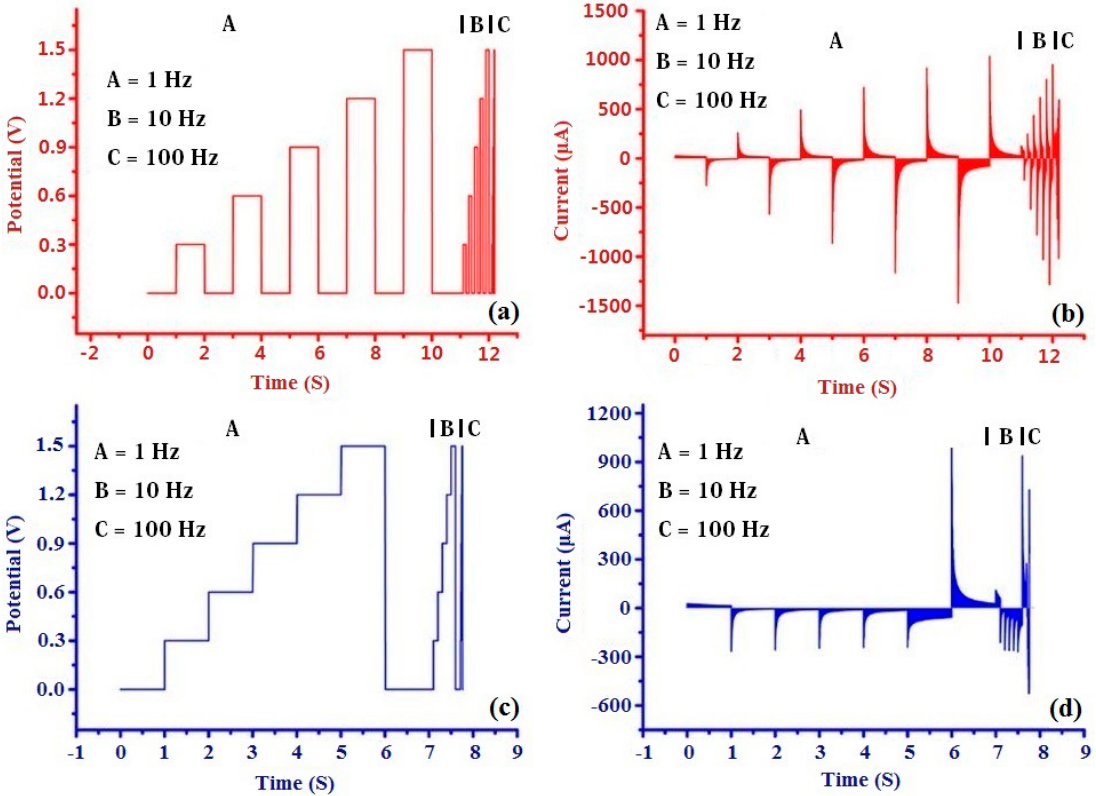
Figure 4. The applied potential waveforms of multi-frequency rectangle pulse voltammetry (MRPV) ( a ) and multi-frequency staircase pulse voltammetry (MSPV) ( c ); the response curves obtained by PABSA/AuNPs/GCE based on MRPV ( b ) and MSPV ( d ).